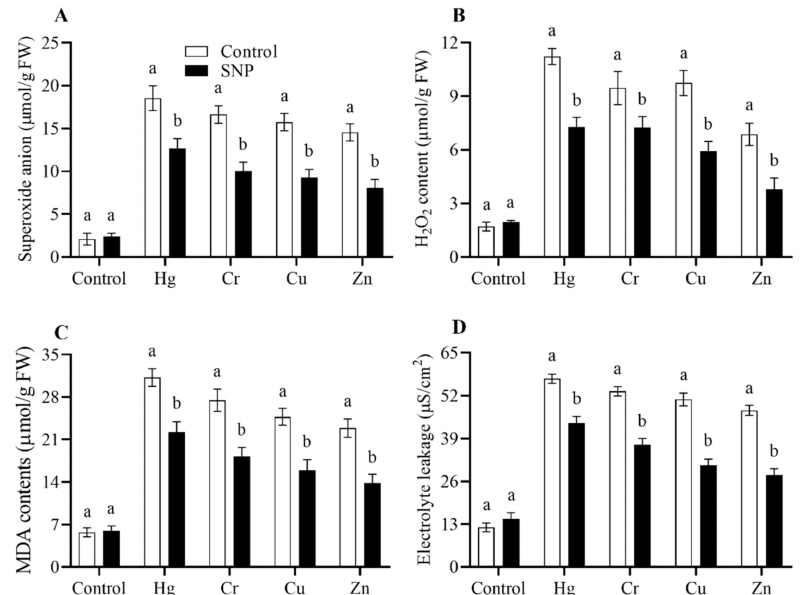
Figure 3. Effects of exogenously applied SNP on rice with or without Hg-, Cr-, Cu-, and Zn-induced stress on rice plants. ( A ) Superoxide anion level, ( B ) H 2 O 2 content, ( C ) MDA level, ( D ) electrolyte leakage. Each data point indicates the mean ± standard deviation ( n = 3). Bars with different letters indicate significant differences, according to Duncan’s multiple range test. The results are compared to the respective controls (Hg-, Cr-, Cu-, and Zn-untreated and Hg-, Cr-, Cu-, and Zn-treated